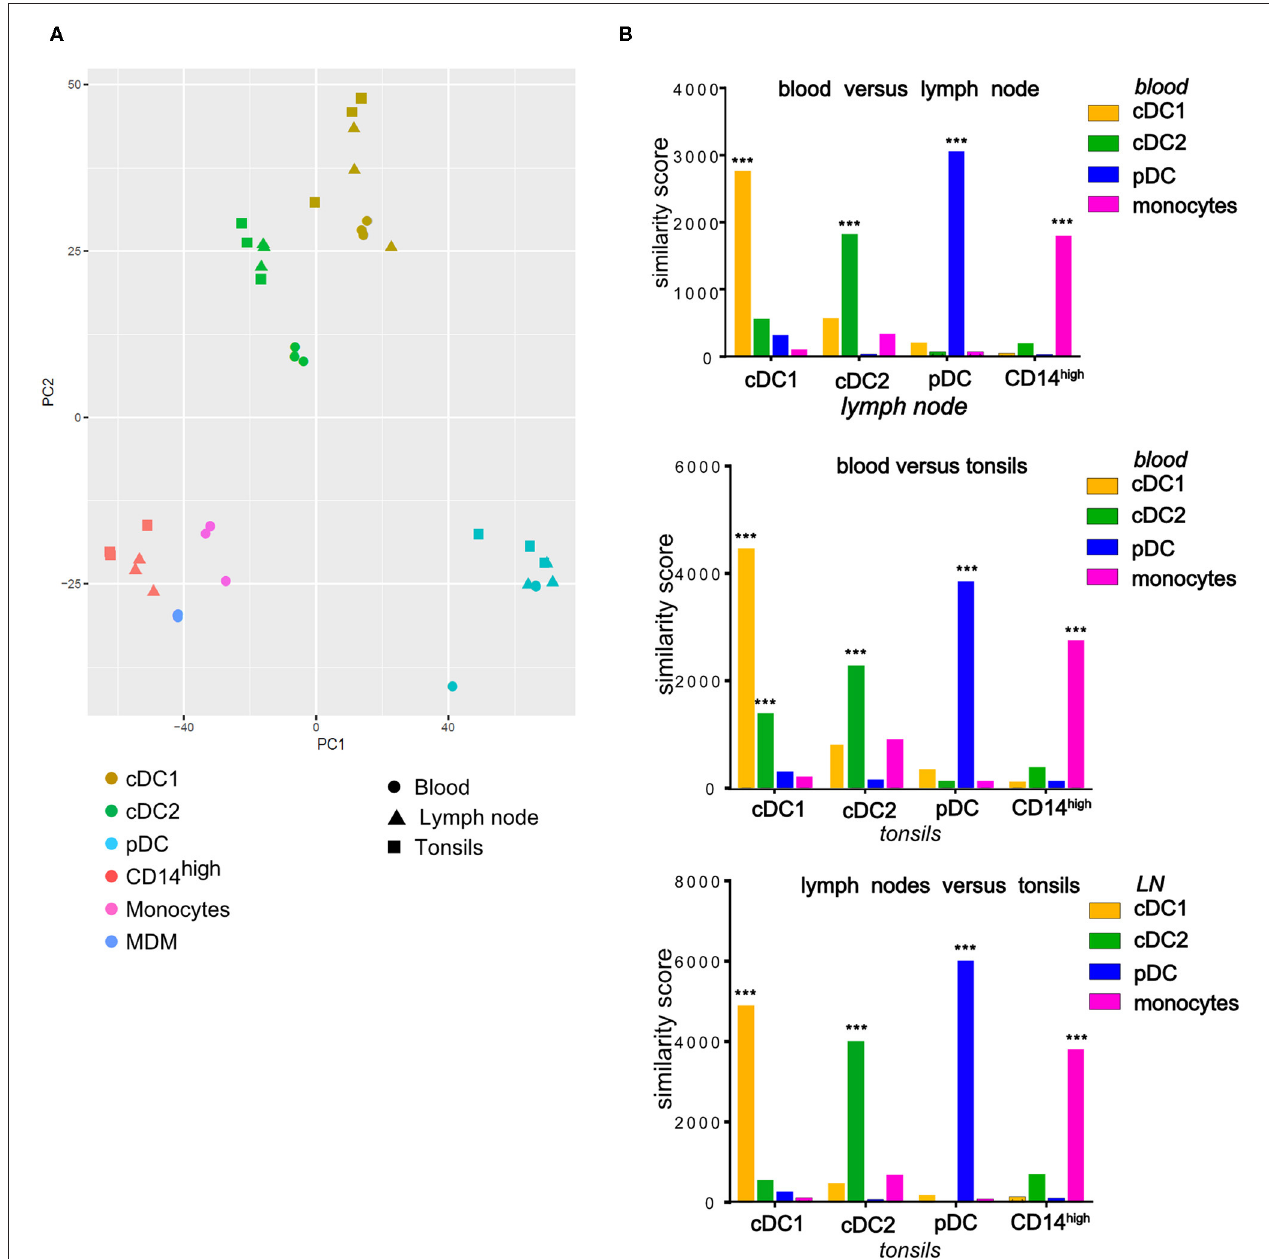
FIGURE 5 | Comparison of transcription profiles of mononuclear phagocytes isolated from tonsils and LN (cDC1, cDC2, pDC, CD14 high ) with their blood counterparts (cDC1, cDC2, pDC, monocytes) as well as with monocyte-derived macrophages (MDM) at homeostasis. Cells isolated from porcine tonsils or lymph nodes were sorted by FACS and their RNA was sequenced. (A) Plot of the first 2 axes from a principal component analysis (PCA) based on the 500 most variable genes. For each compartment (blood, tonsils, lymph nodes), data were obtained from three different animals. (B) Each cell-type specific signature was compared to all signatures of subsets from a second tissue and a similarity score was calculated. To assess the statistical significance of the similarity scores, the observed values were compared to a null distribution obtained by reshuffling the genes. *** = empirical p -value < 0.001.